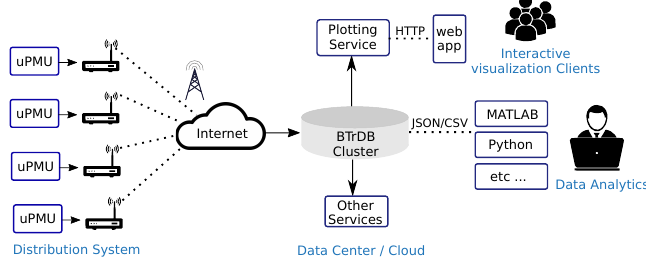
Figure 2. Micro-Phasor Measurement Units ( µ PMU) data system architecture (adapted from Reference